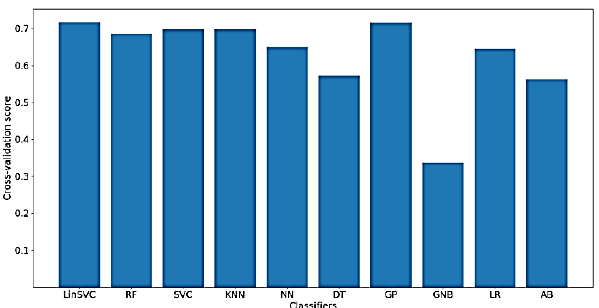
Figure 13. Performance of implemented classifiers for the classification of FA scores using no DC component ( NoDC ) data and only time-domain features.